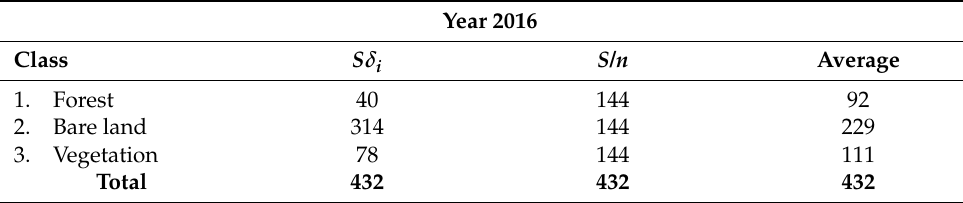
Table 13. Samples stratification for the classified data of the year